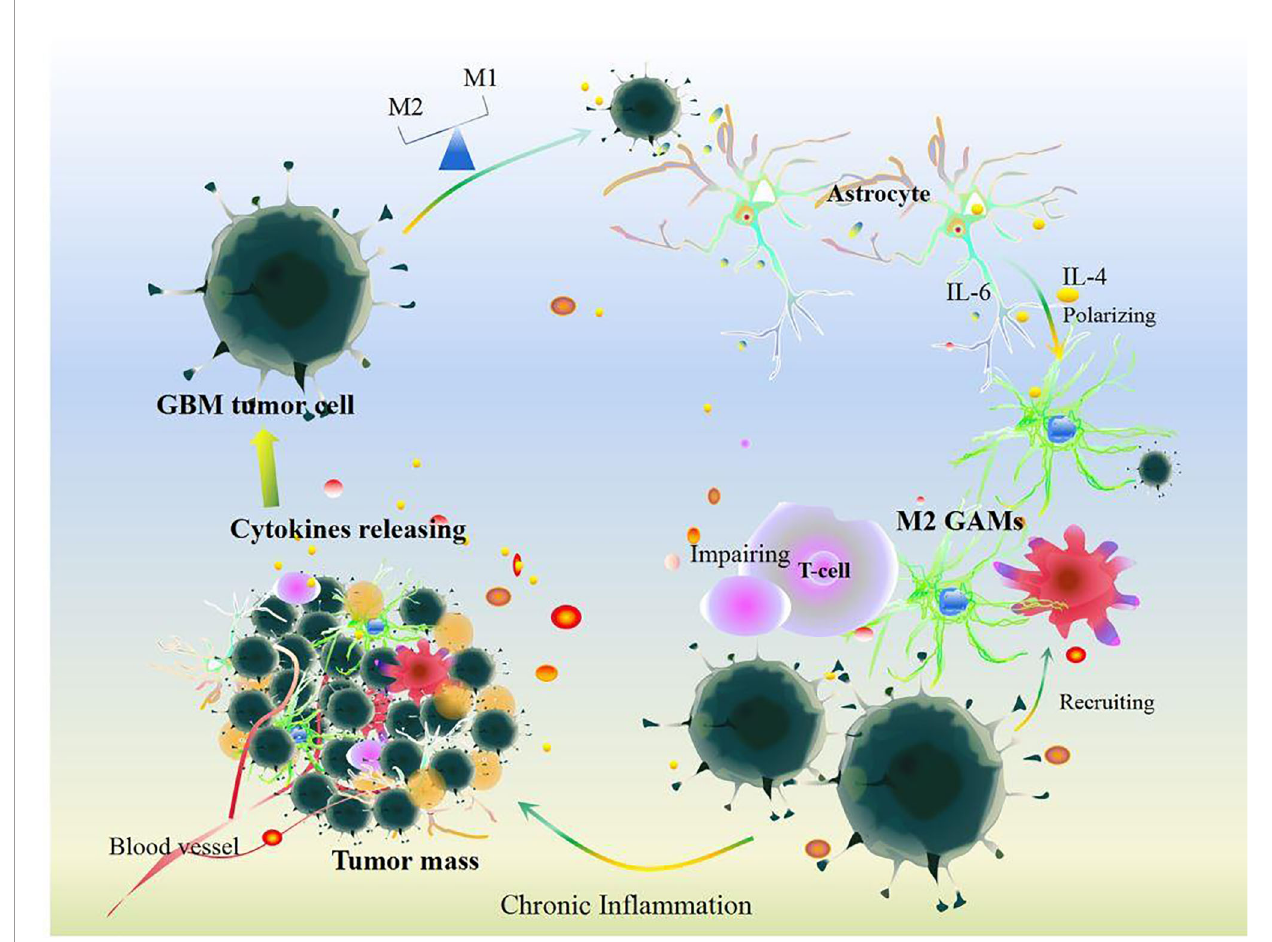
FIGURE 3 | Cellular communication in GBM. Under chronic in fl ammation, cytokines released by cells including somatic cells and other immune cells can recruit GAM in fi ltration after the survey and chemotherapy and immunotherapy treatments in GBM. Additionally, GBM tumor cells induce GAM polarization resulting in disrupting the balance of M1 and M2 GAMs. Meanwhile, GBM tumor cells communication with astrocytes and other somatic cells could impair T cell function and release plenty of cytokines including IL-6, IL-4, IL-10, IL-8, IL-1, TGF- b , Arg-1, and VEGF. All these changes aggravate GBM tumor